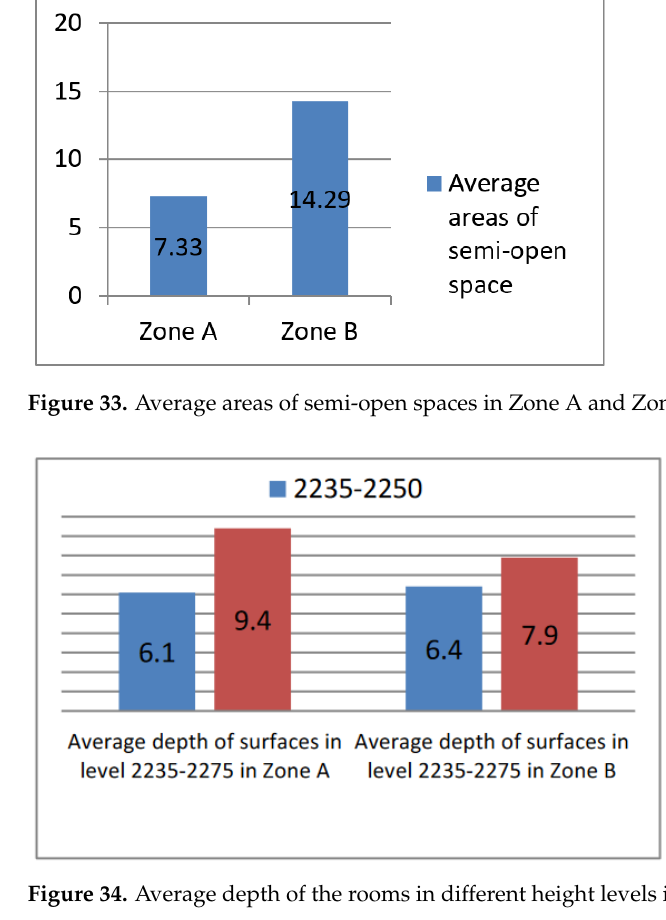
Figure 34. Average depth of the rooms in different height levels in Zone A and Zone B.